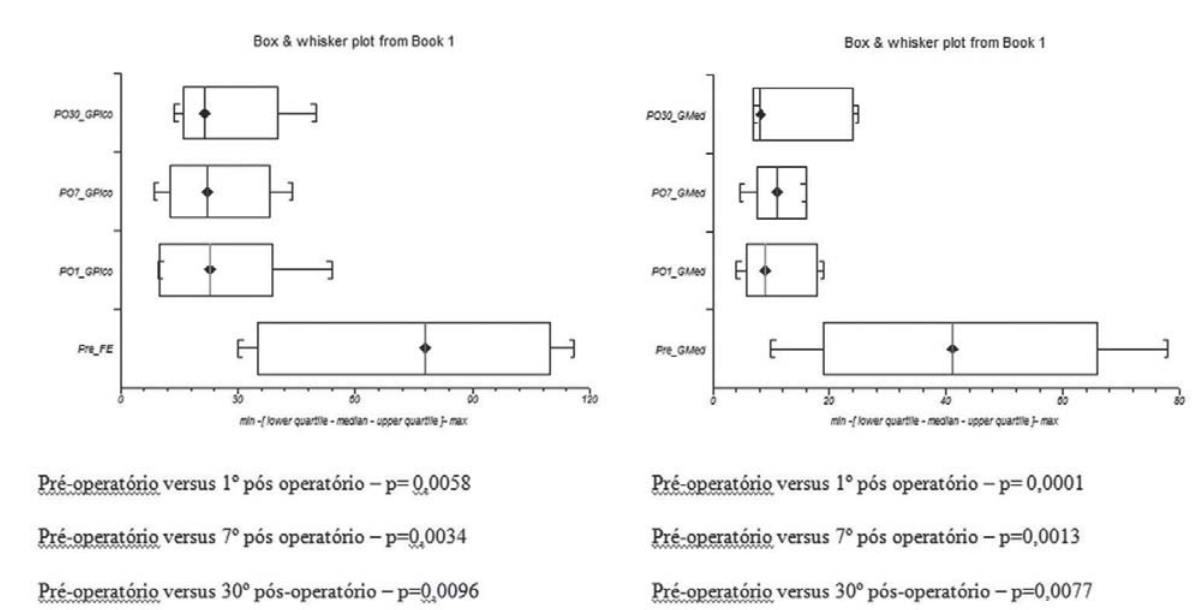
Fig. 5 - A. Gradientes transvalvares aórticos de pico no pré-operatório, 1º pós-operatório, 7º pós-operatório e 30º pós-operatório. B. Gradientes transvalvares aórticos médios no pré-operatório, 1º pós-operatório, 7º pós-operatório e 30º